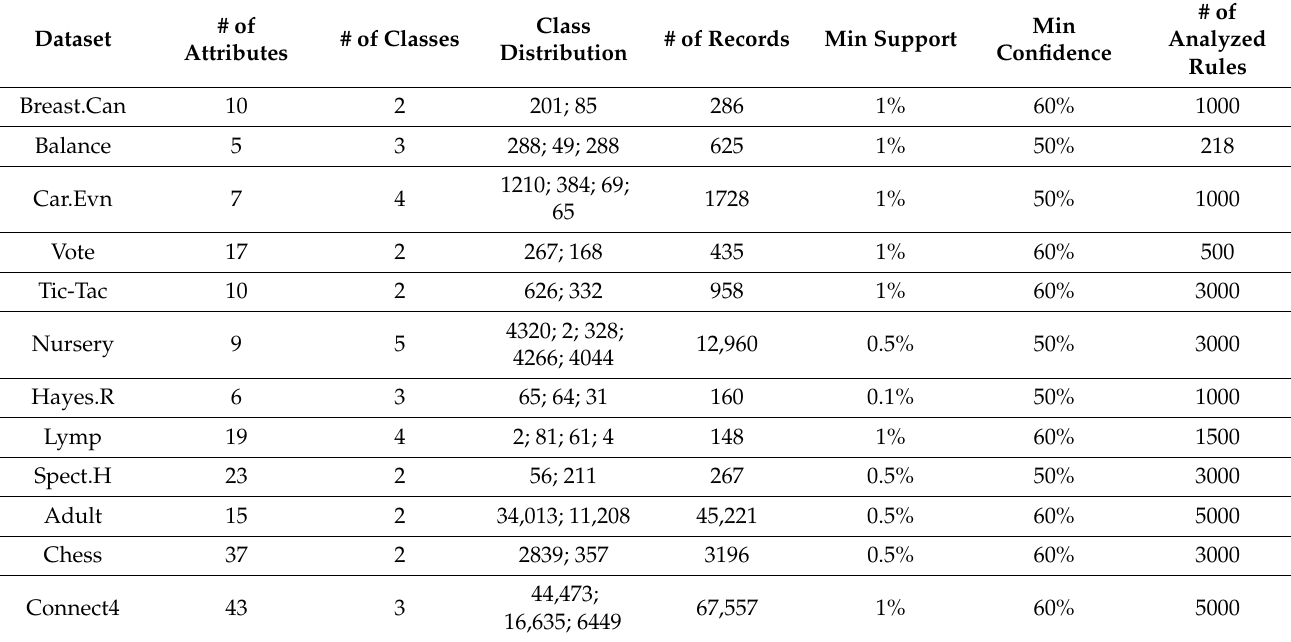
Table 1. Description of datasets and AC algorithm